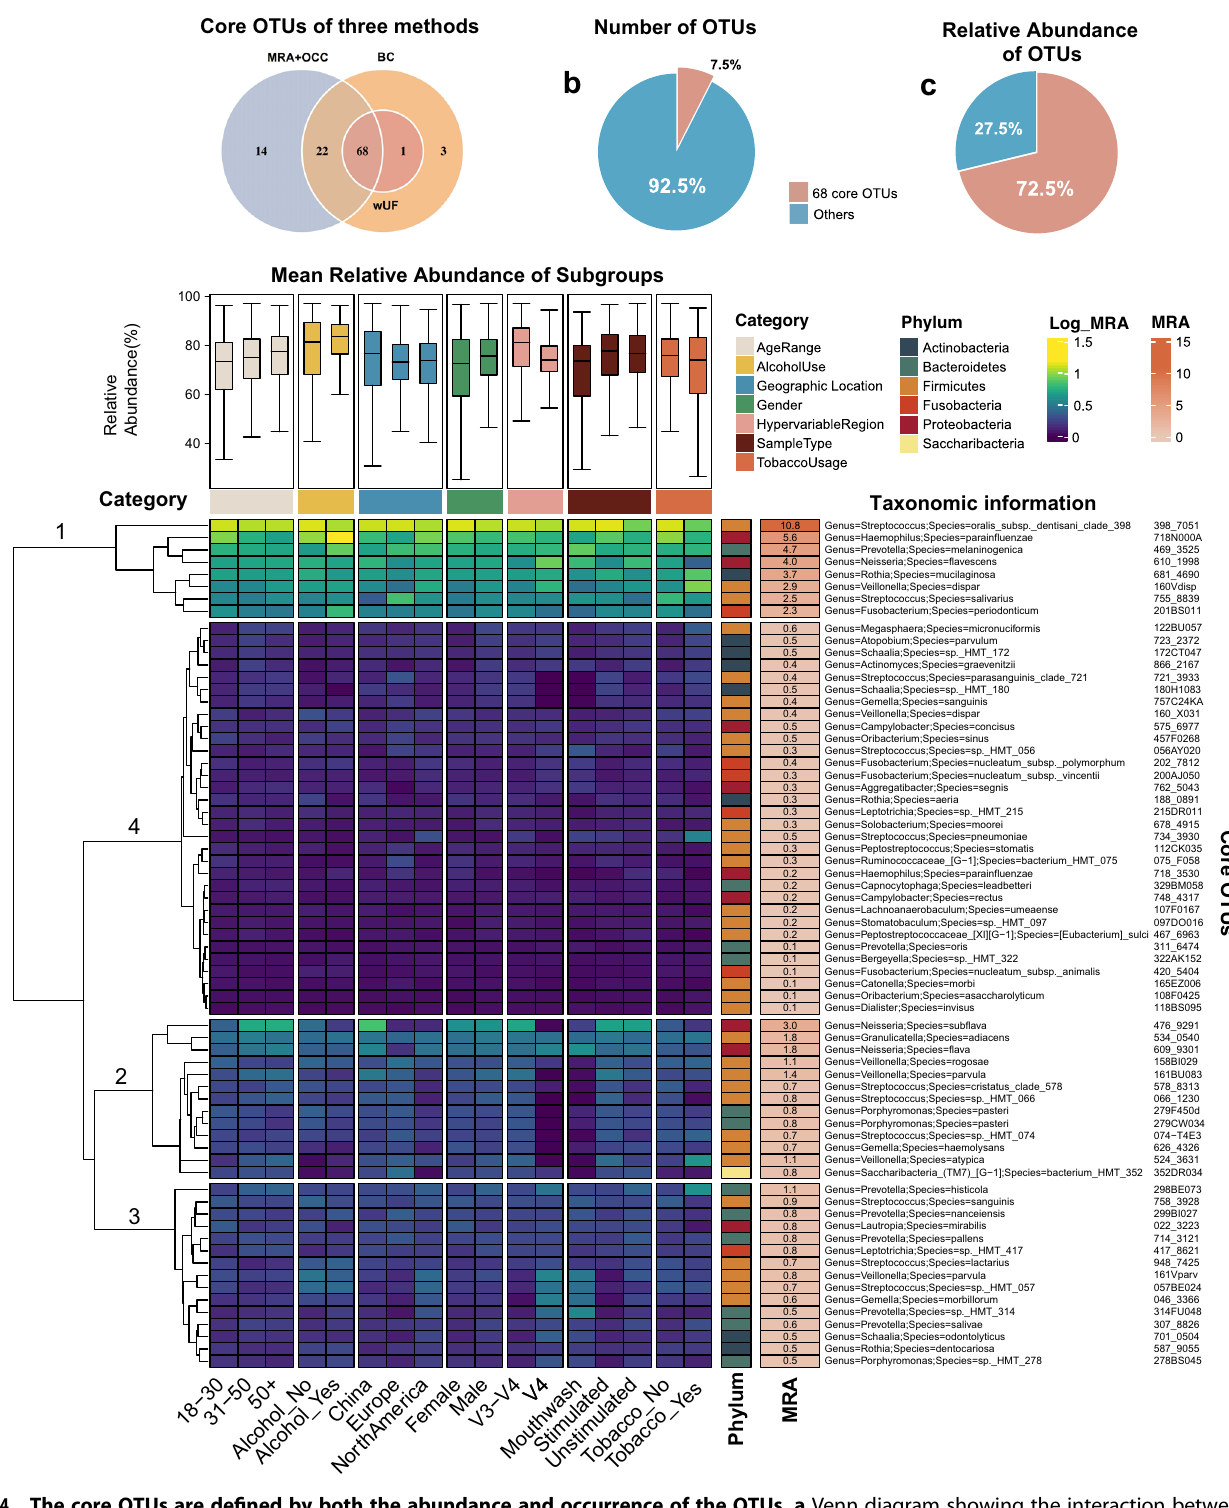
Fig. 4 The core OTUs are de fi ned by both the abundance and occurrence of the OTUs. a Venn diagram showing the interaction between three methods used to de fi ne the core. Sixty-eight OTUs were de fi ned as the core for all methods. (MRA + OCC: The thresholds were set on mean relative abundance and occupancy to de fi ne the core; BC: The method adapted from Shade and Stopnisek using Bray – Curtis similarity; wUF: The method adapted from Shade and Stopnisek using weighted UniFrac distance). b Pie chart showing the number of the core (pink) versus other OTUs (blue) identi fi ed in percentage. c Pie chart showing the relative abundance of the core and other OTUs across all samples. d Relative abundance of 68 core OTUs across sub-groups classi fi ed by seven categories. e Heatmap showing the log-transformed mean relative abundance of each core OTU at each level of different